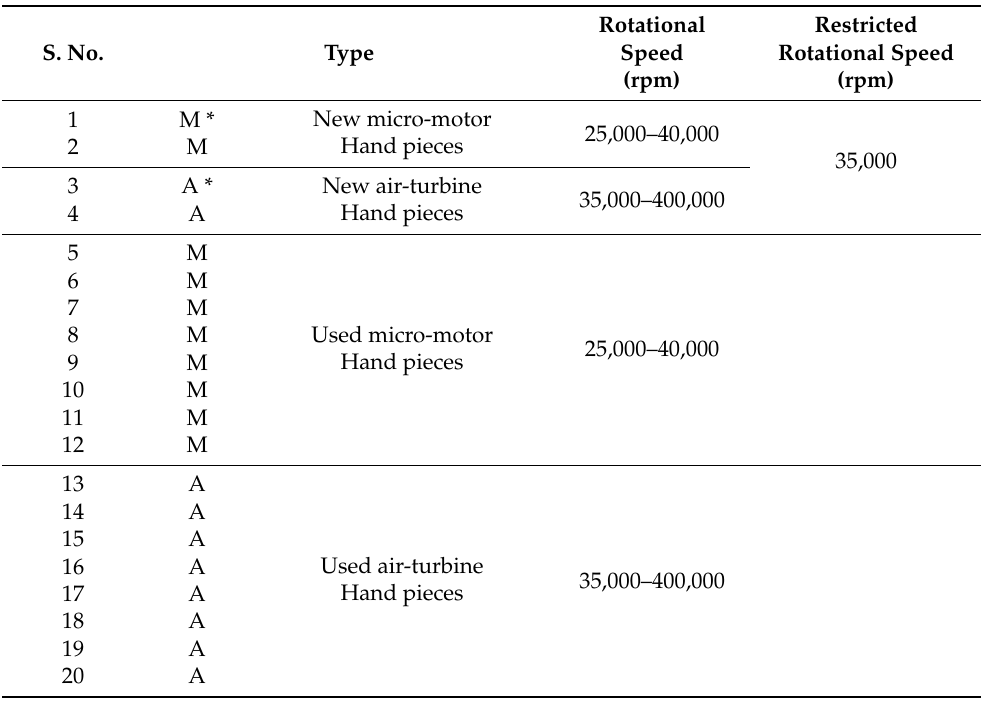
Table 1. Number of utilized hand